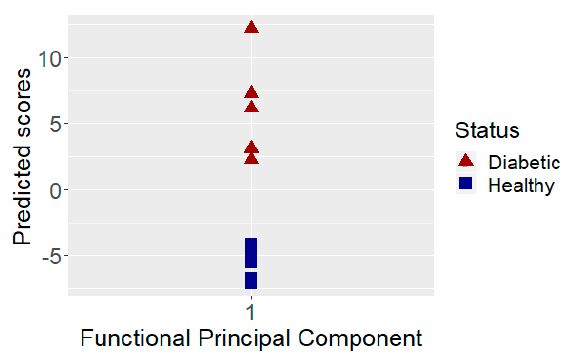
Figure 4. Predicted scores for the test sample, using only the first functional principal component.